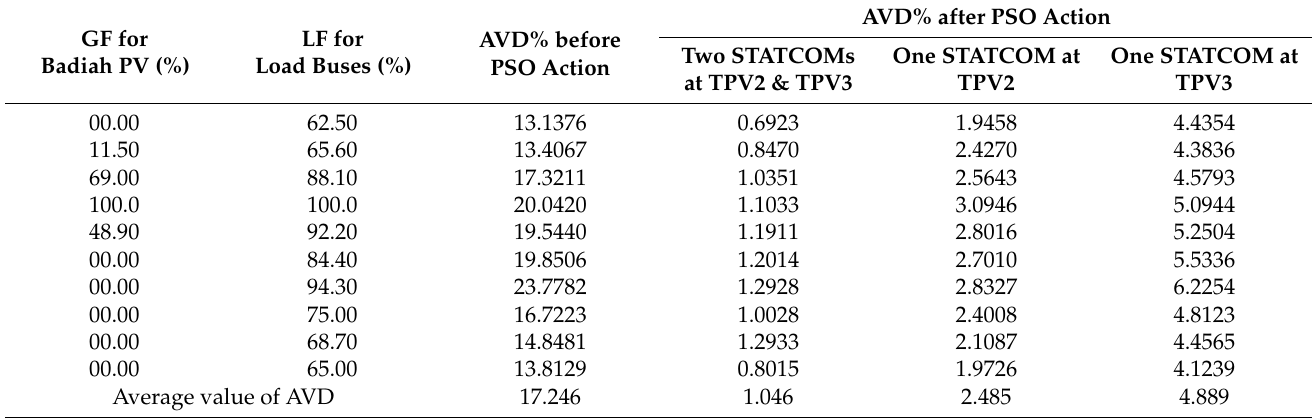
Table 9. Average voltage deviation after PSO action on STATCOMs at different